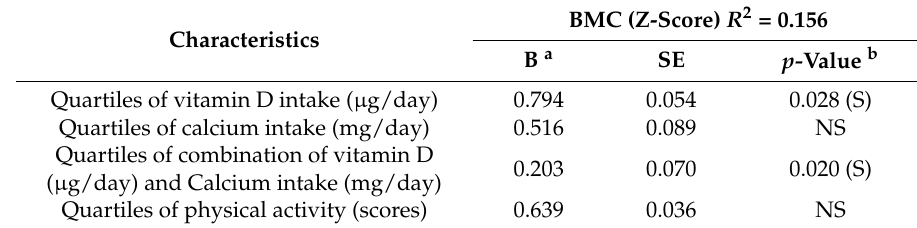
Table 4. Associations between BMC and quartiles of dietary calcium, vitamin D, and physical activity of individuals in the Malaysian Health and Adolescents Longitudinal Research Team Cohort study (MyHeARTs) (unstandardized parameter